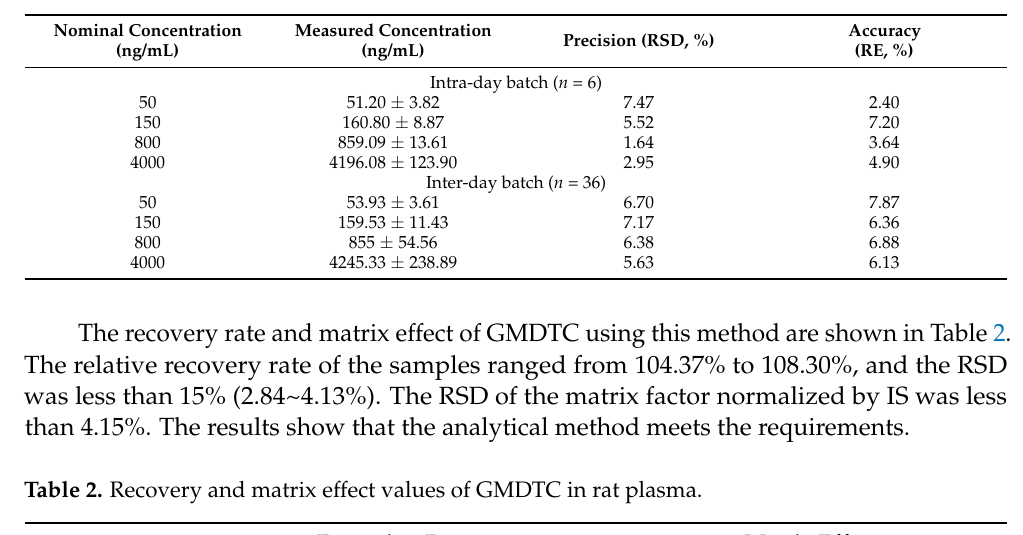
Table 1. Precision and accuracy values of GMDTC in rat plasma.